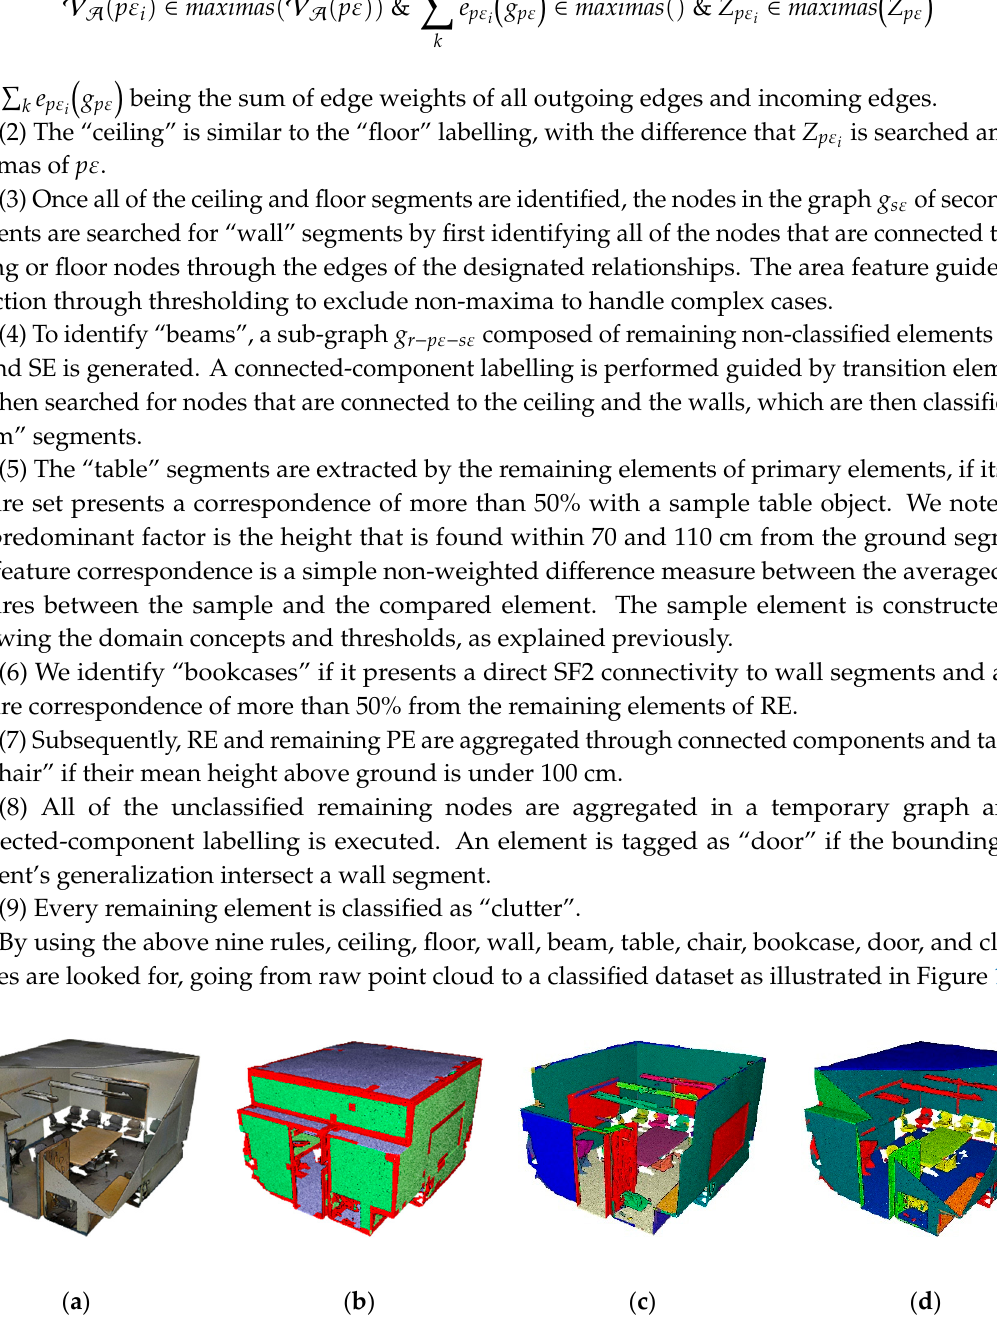
Figure 14. ( a ) Raw point cloud; ( b ) {PE, SE, TE, RE} groups of voxels; ( c ) Connected Elements; and, ( d ) Classified point cloud.